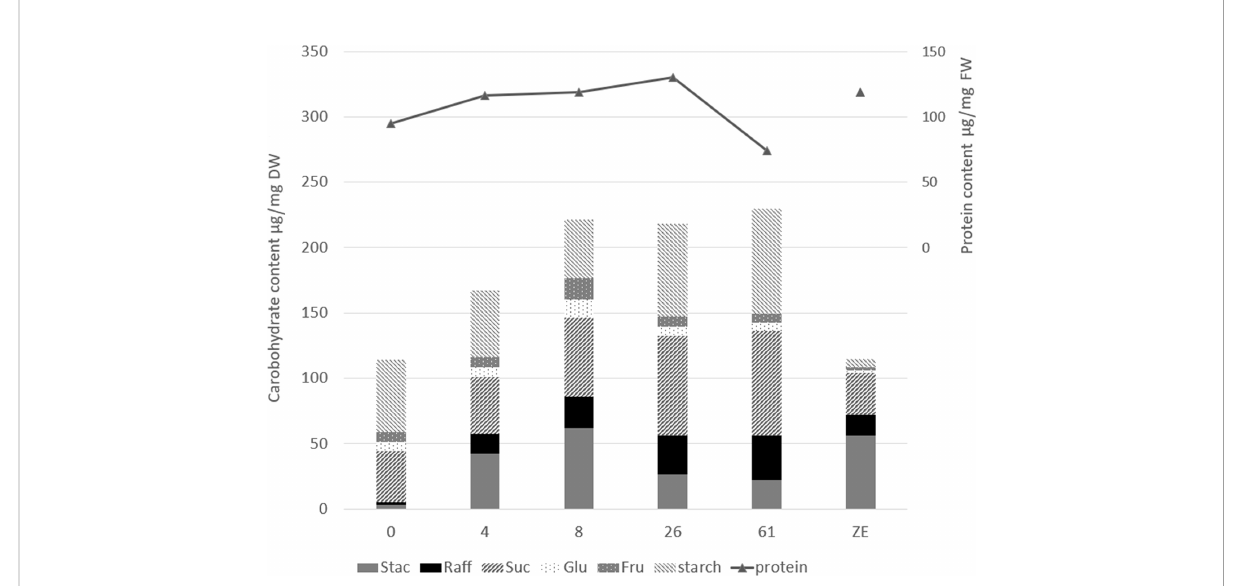
FIGURE 5 Storage compound content of the cotyledonary somatic embryos at the end of maturation (0), after 4, 8, 26, or 61 weeks of cold storage (4, 8, 26, or 61), or in the mature zygotic embryos (ZE). Values are means of fi ve replicates for carbohydrate assay (on the left axis) and three replicates for protein assay (on the right axis). The statistical results of the multiple comparisons of means are given in the (Supplementary Table 10). Stac, stachyose; Raff, raf fi nose; Suc, sucrose; Glu, glucose; Fru, fructose; DW, dry weight; FW, fresh